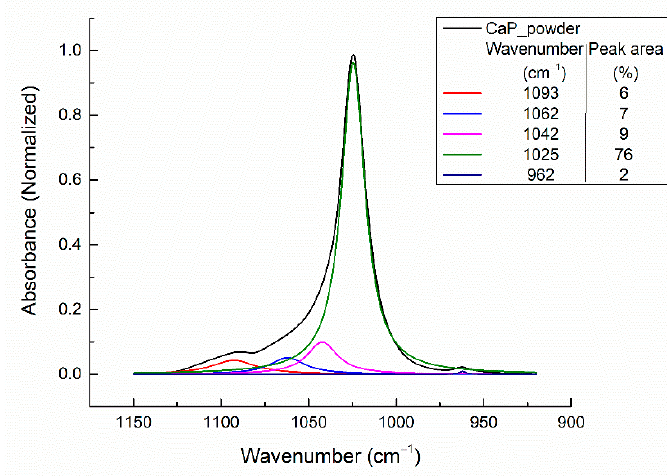
Figure 9. Deconvoluted IR bands of CaP sputtering